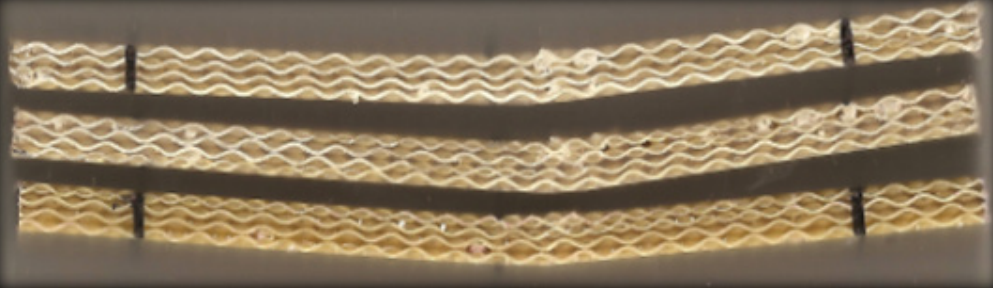
Figure 15. Fracture characteristic – HSCL laminate – three-point bending.